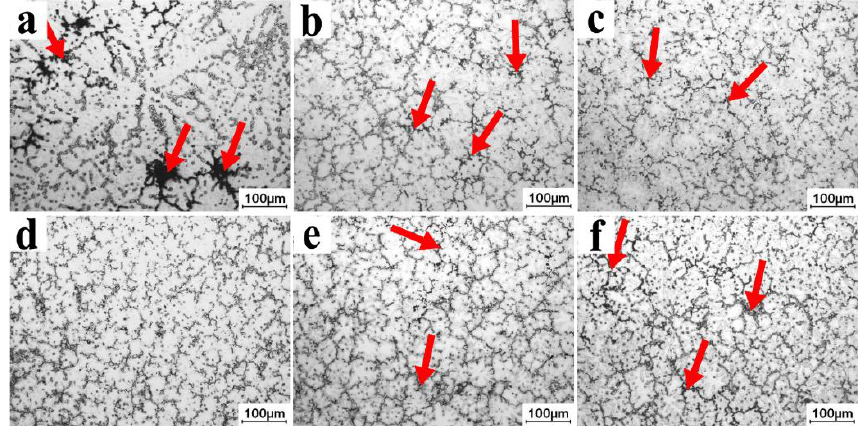
Figure 2. OM micrographs of the Grp/AZ91D composites with different Grp contents: ( a ) 0 wt.%, ( b ) 0.5 wt.%, ( c ) 1.0 wt.%, ( d ) 1.5 wt.%, ( e ) 2.0 wt.%, and ( f ) 2.5 wt.%.(Red arrows: the defects of the composites)